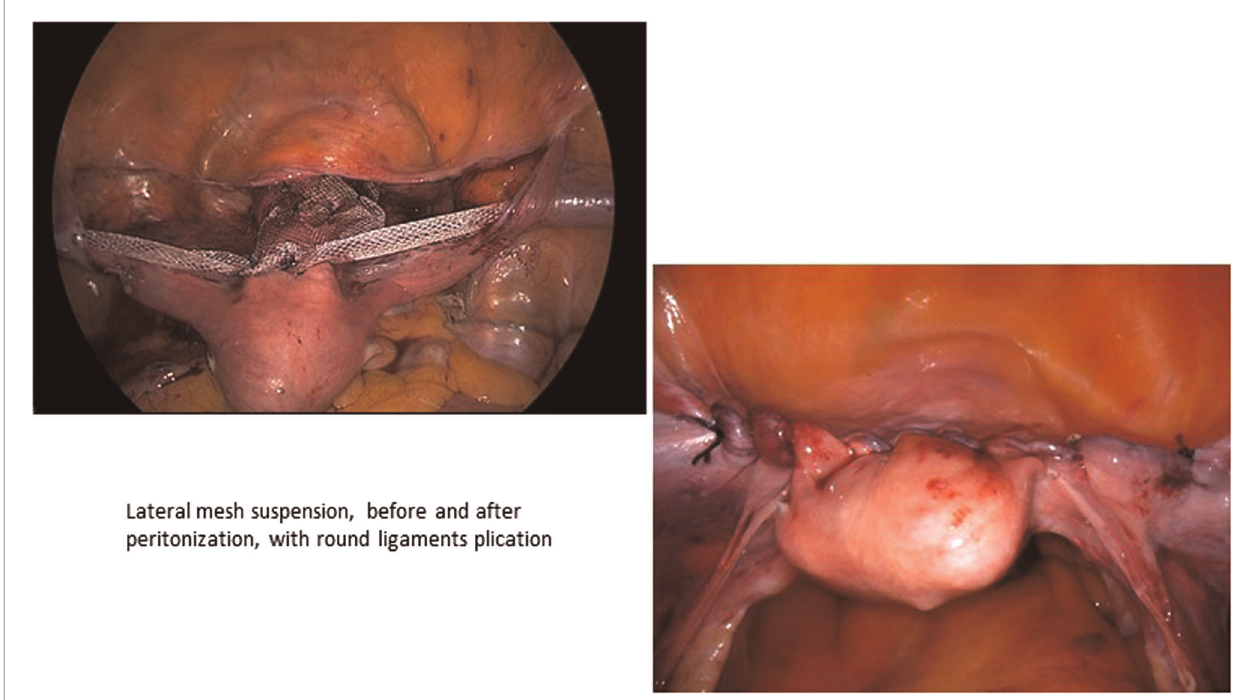
FIGURE 1 | Lateral mesh suspension, before and after peritonization, with round ligaments